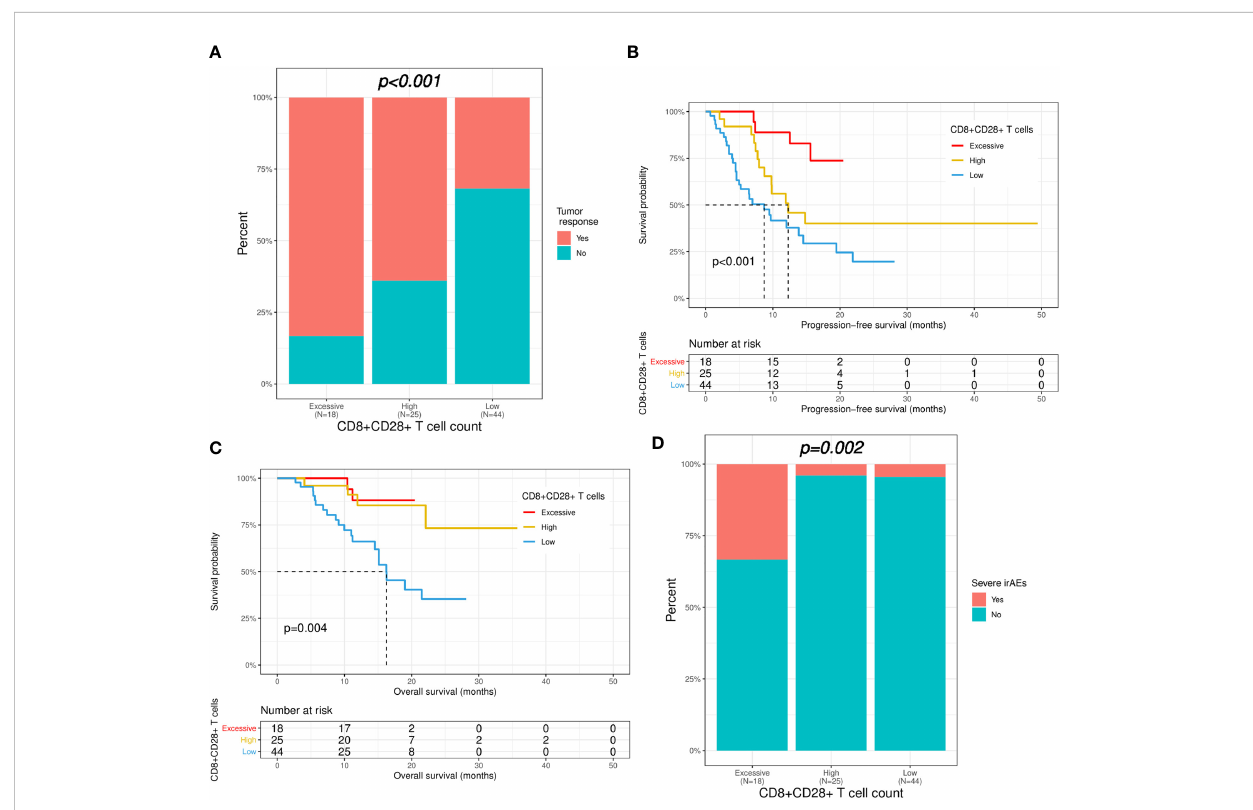
FIGURE 4 Correlation of CD8+CD28+ T-cell count with immunotherapy ef fi cacy and safety. Patients were divided into three groups based on the level of CD8 +CD28+ T cells (excessive: ≥ 309; high: 309-190; low: <190). (A) Comparison of immunotherapy response between the three groups. (B, C) Kaplan − Meier curves of progression-free survival and overall survival in the three groups. (D) Comparison of severe irAEs between the three groups. irAEs, immune-related adverse events.